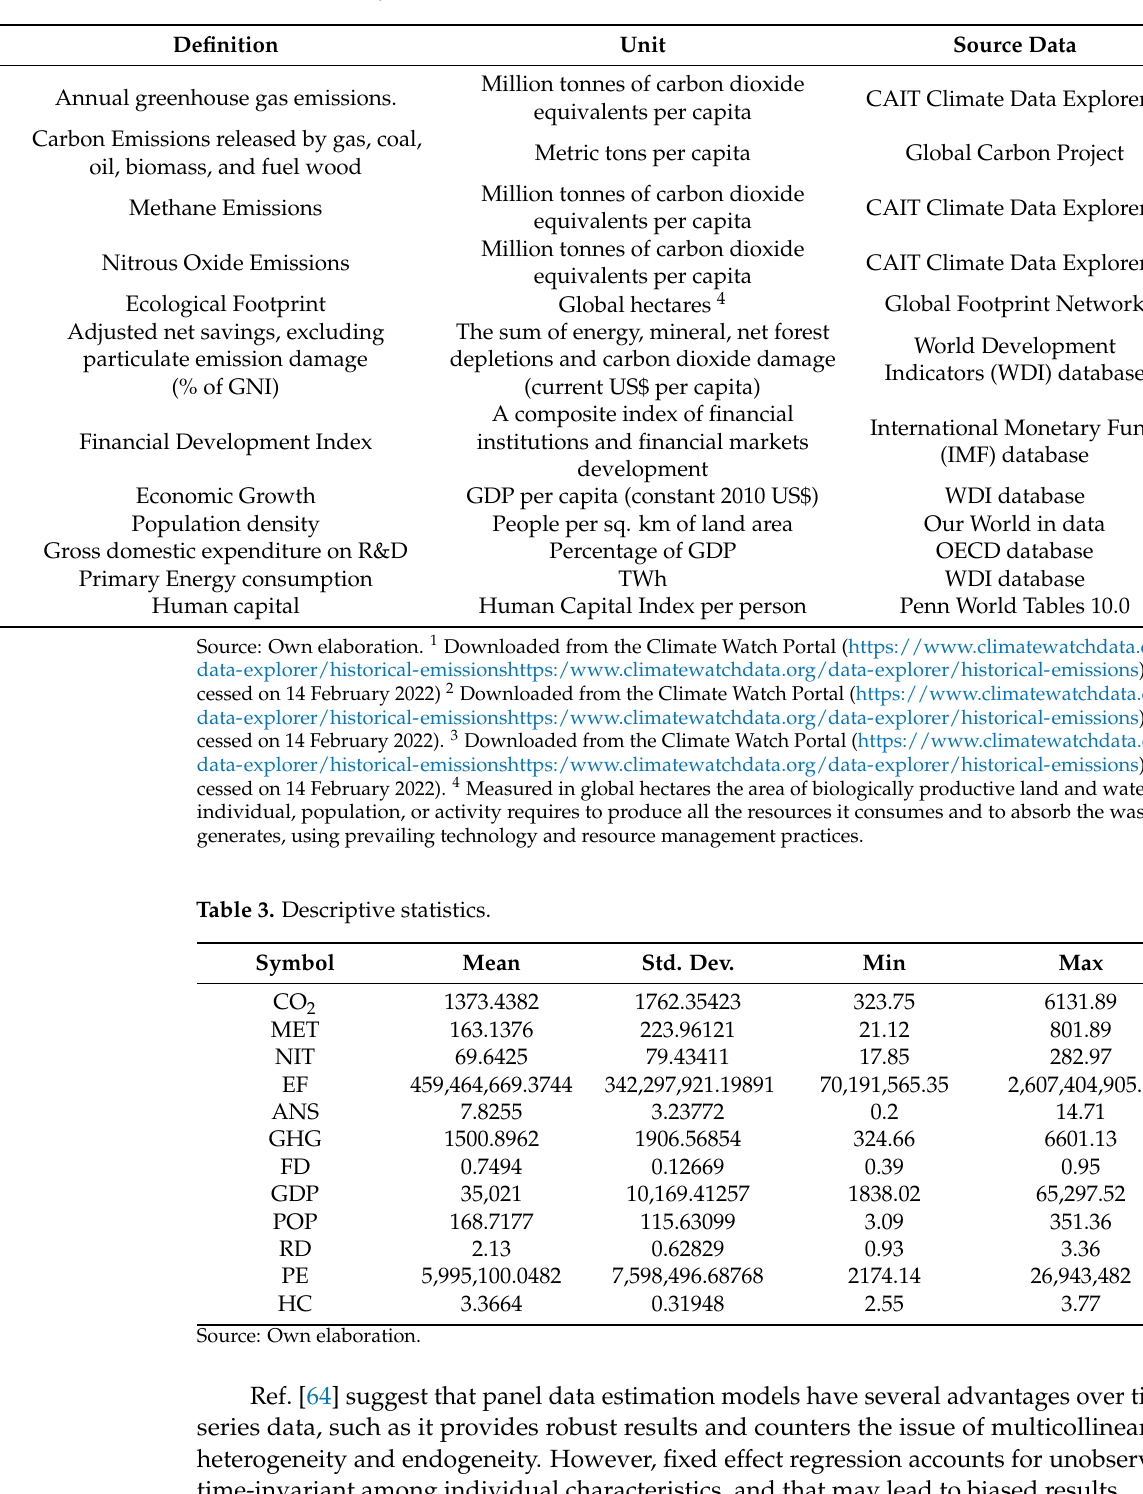
Table 2. Variable synthesis.